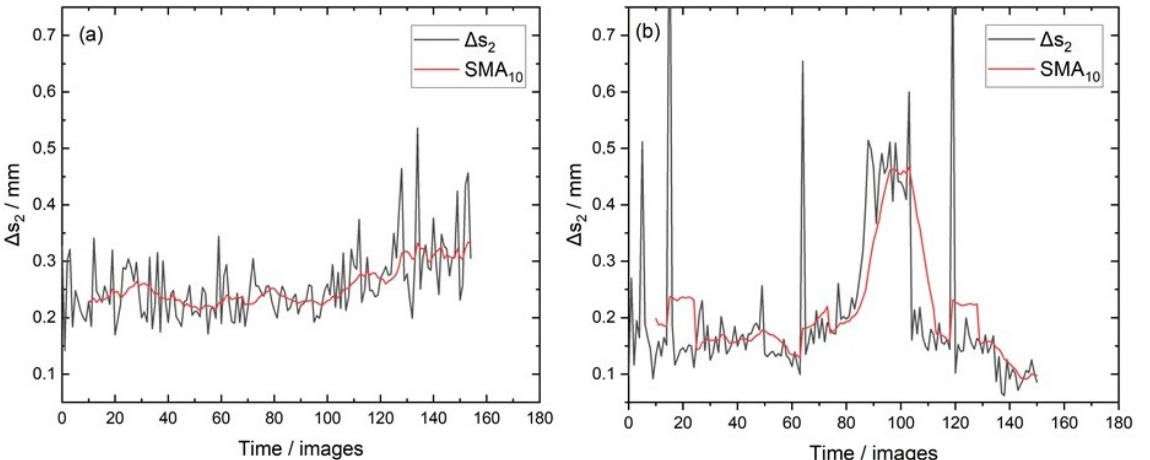
Figure 6. Mean deviation of the first two rows printed in each test pattern of two different long-term tests and the simple moving average with a window size of 10 images (SMA 10 ), respectively. (a) Long-term test with increasing trend. (b) Long-term test performed with more stable ink formulation. No trend detected according to the Mann–Kendall